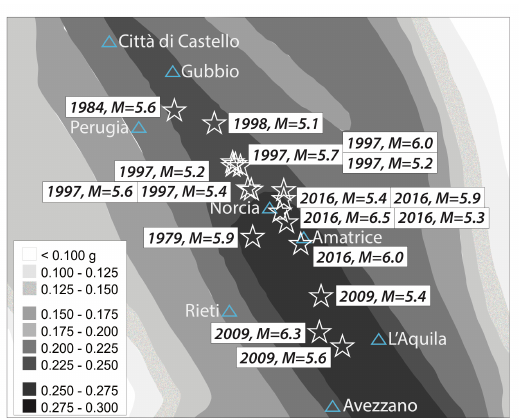
Figure 1. Epicenters of the earthquakes with M > 5.0 (white stars) related to the most important seismic se- quences occurred in the target region over the last 35 years and the maximum expected values of peak ground acceler- ation. In 2004, it was published the seismic hazard map of Italy (http://zonesismiche.mi.ingv.it) that provides a pic- ture of the most hazardous geographic regions. The seismic hazard map of Italy (GdL MPS, 2004; rif. Ordinanza PCM del 28 aprile 2006, n. 3519, All. 1b) provides the 10% probability of exceedance in 50 years of the horizontal acceleration at rock sites (i.e., Vs30>800 m/s; cat. A, 3.2.1 of the D.M. 14.09.2005) - units of gravity (g=9.81m/s2).